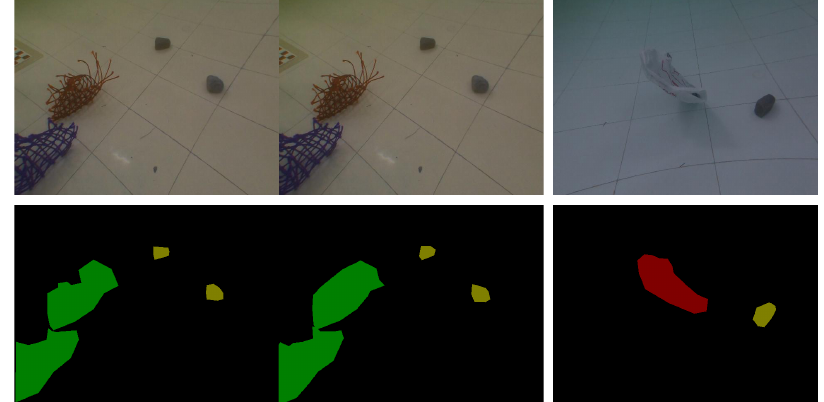
Figure 1. Illustrative examples of the dataset, including two types in each image.